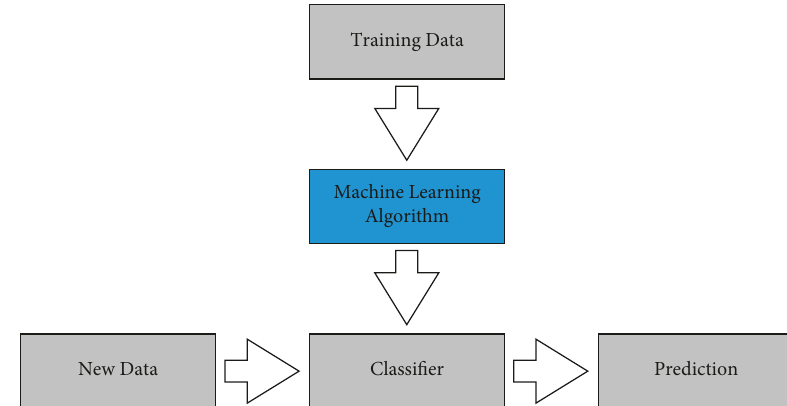
Figure 4: Na¨ıve Bayes model (adapted from